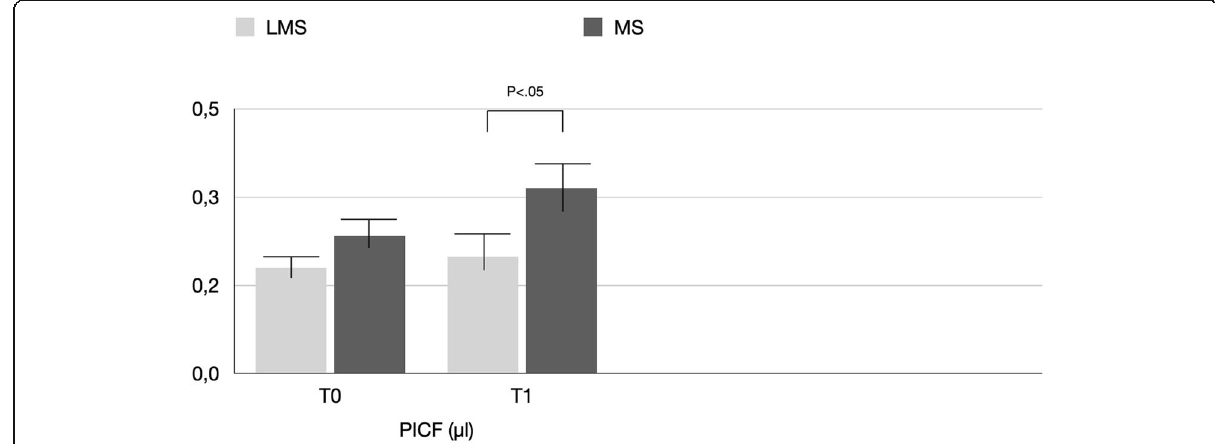
Fig 4 Mean values of PICF ( μ l) detected in the LMS and MS groups